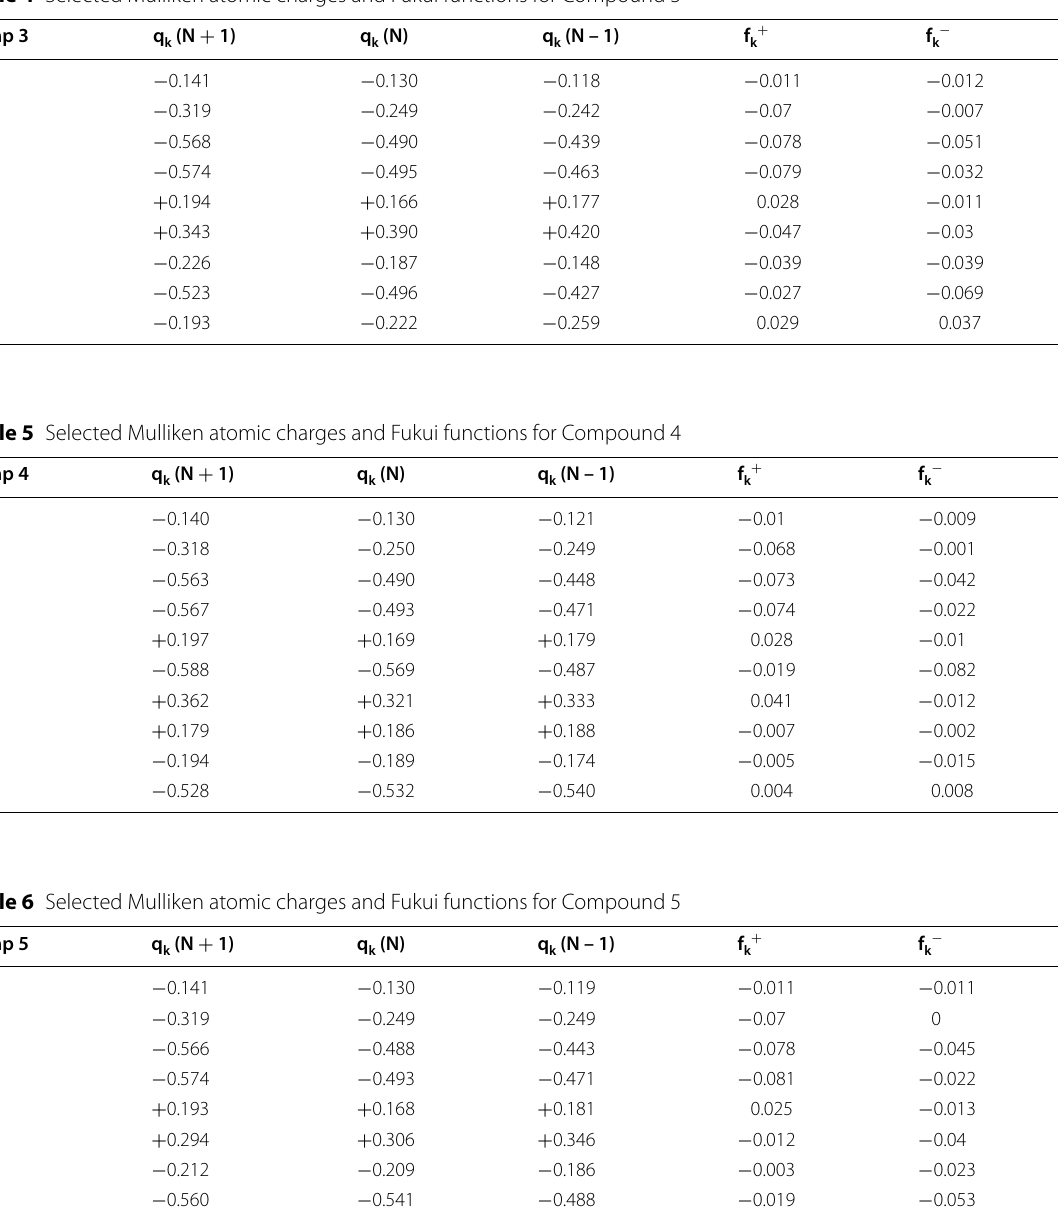
Table 4 Selected Mulliken atomic charges and Fukui functions for Compound 3